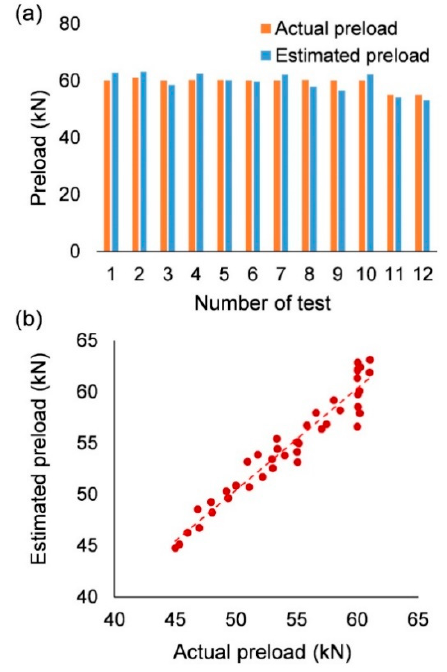
Figure 11. ( a ) Comparison between estimated preloads from the L-PMS and actual preloads measured by the washer-type load cell: ( a ) a bar chart near the actual preload of 60 kN and ( b ) a scatter plot for the actual preloads from 45 kN to 60 kN.